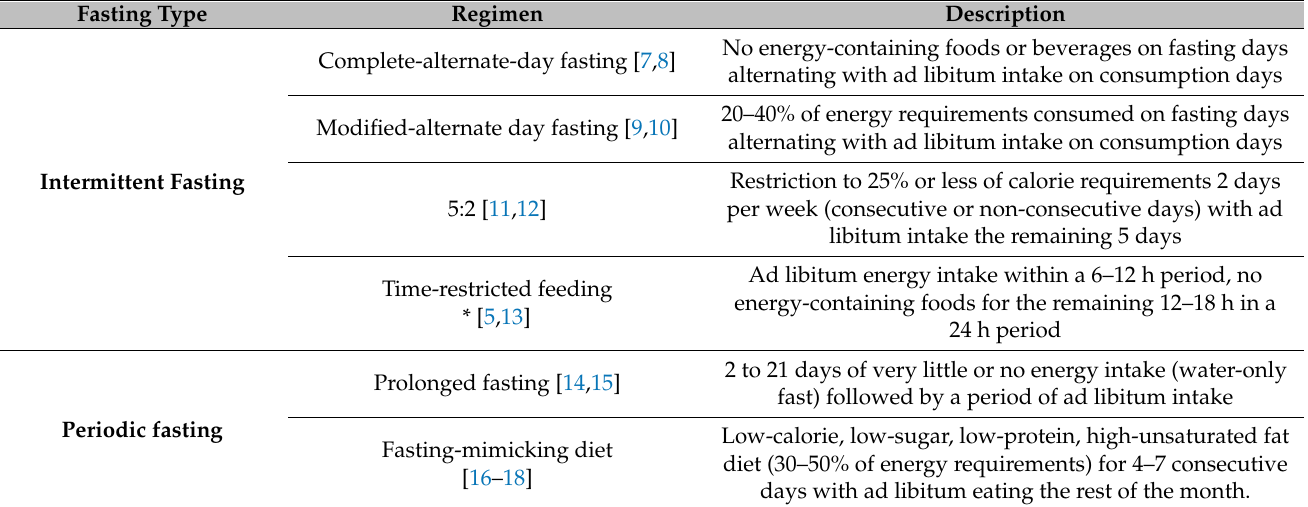
Table 1. Description of common fasting